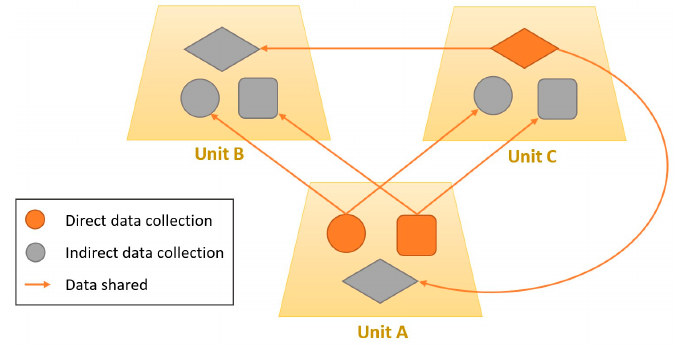
Figure 6. Example of data sharing between units.